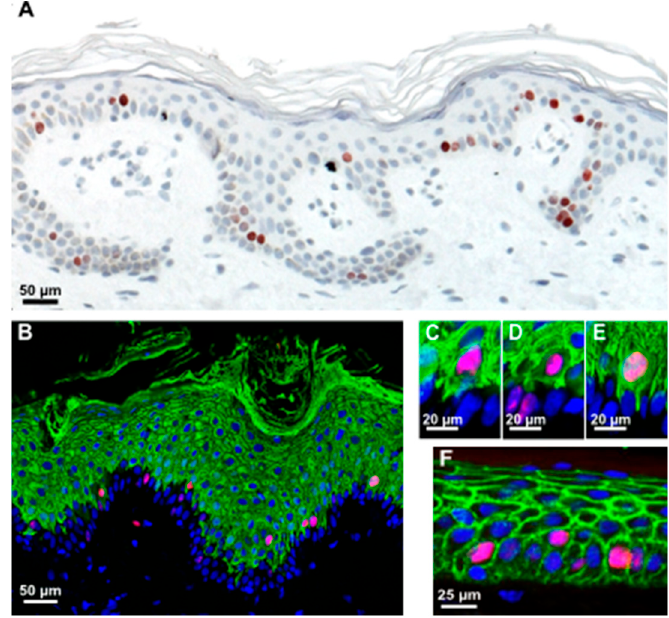
Figure 3. Most suprabasally-dividing cells are already committed to differentiation. ( A ) Immunohistochemistry of skin sections revealing Ki67-positive mitotic cells in both the basal and suprabasal cell layers in normal human skin; ( B ) Many mitotic cells (red, stained with anti-Ki67) are positive for the early differentiation marker K10 (green) in normal human skin; ( C – E ) Insets of ( B ) reveal that many of these suprabasally-dividing cells often retain cytoplasmic connections, reaching the BM, while few are really separated from the BM ( D ), as indicated by a complete lining with E-cadherin ( F ).